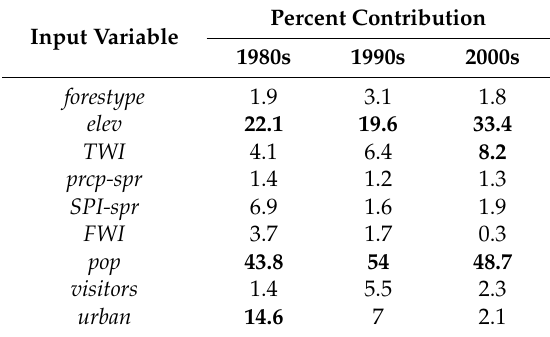
Table 2. Percent contribution of each input variable to forest fire probability during the 1980s, 1990s, and 2000s (Maxent Analysis). Percent Contribution Input Variable 1980s